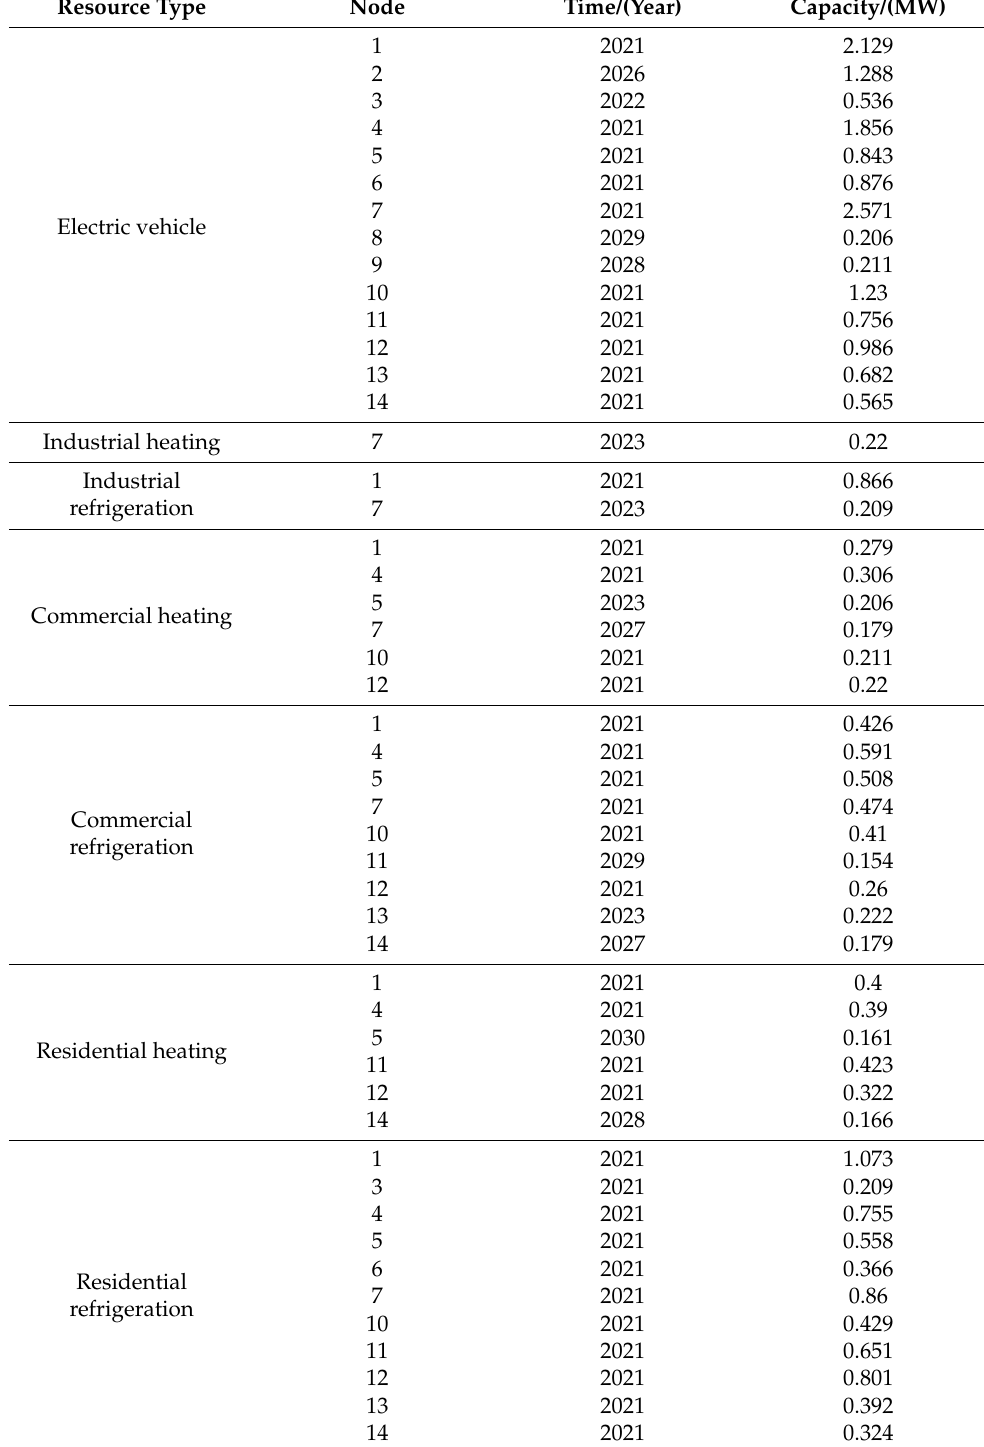
Table 3. Load configuration results from 2021 to